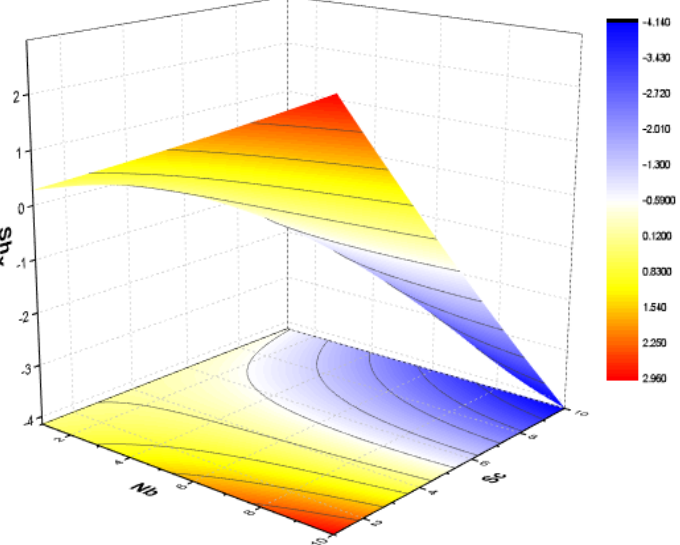
Figure 23. Impact of 𝑁𝑏𝑎𝑛𝑑𝑆𝑐 on Sherwood number. Table 2. Numerical values for Friction Drag Coefficient at both walls.